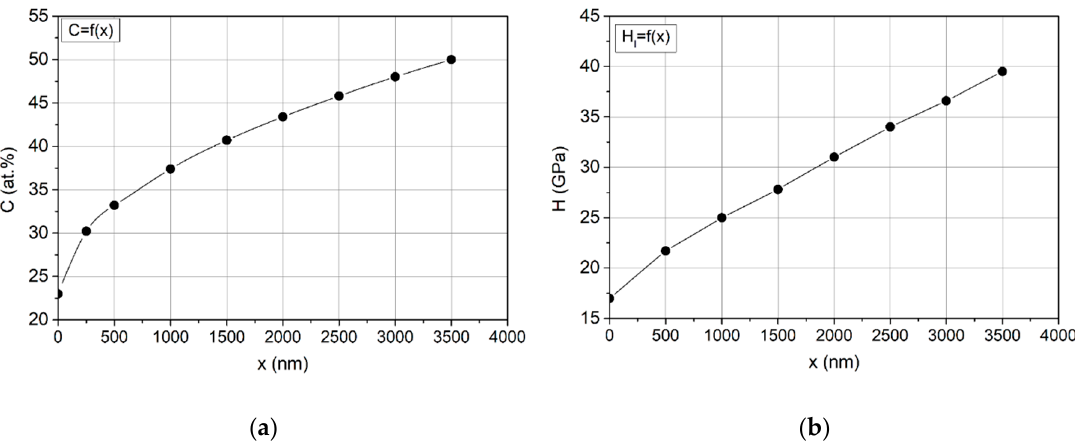
Figure 7. ( a ) Square root change in carbon content in the concentration range of 0–50 at.% determined using Formula (3) and ( b ) hardness change in coating determined based on carbon content profile accepted and changes in hardness calculated according to mixtures rule (Formula (1)).